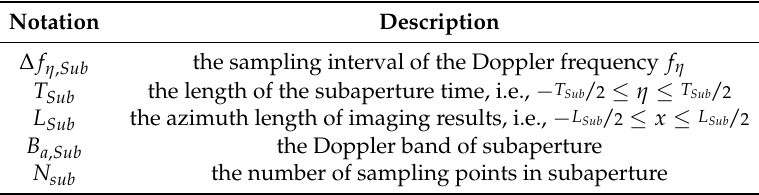
Table 2. Notations used in the subaperture